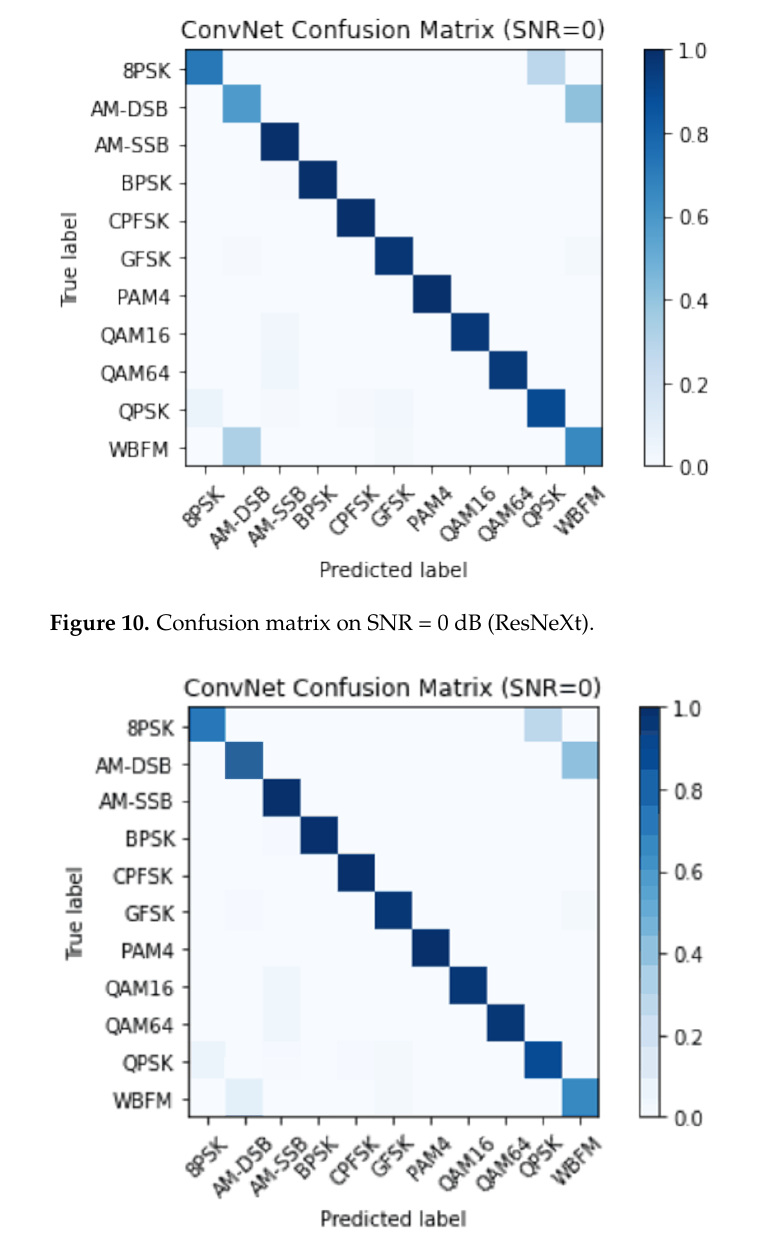
Figure 11. Confusion matrix on SNR = 0 dB (RFSE-ResNeXt). Table 2. CPFSK recognition at SNB = − 10